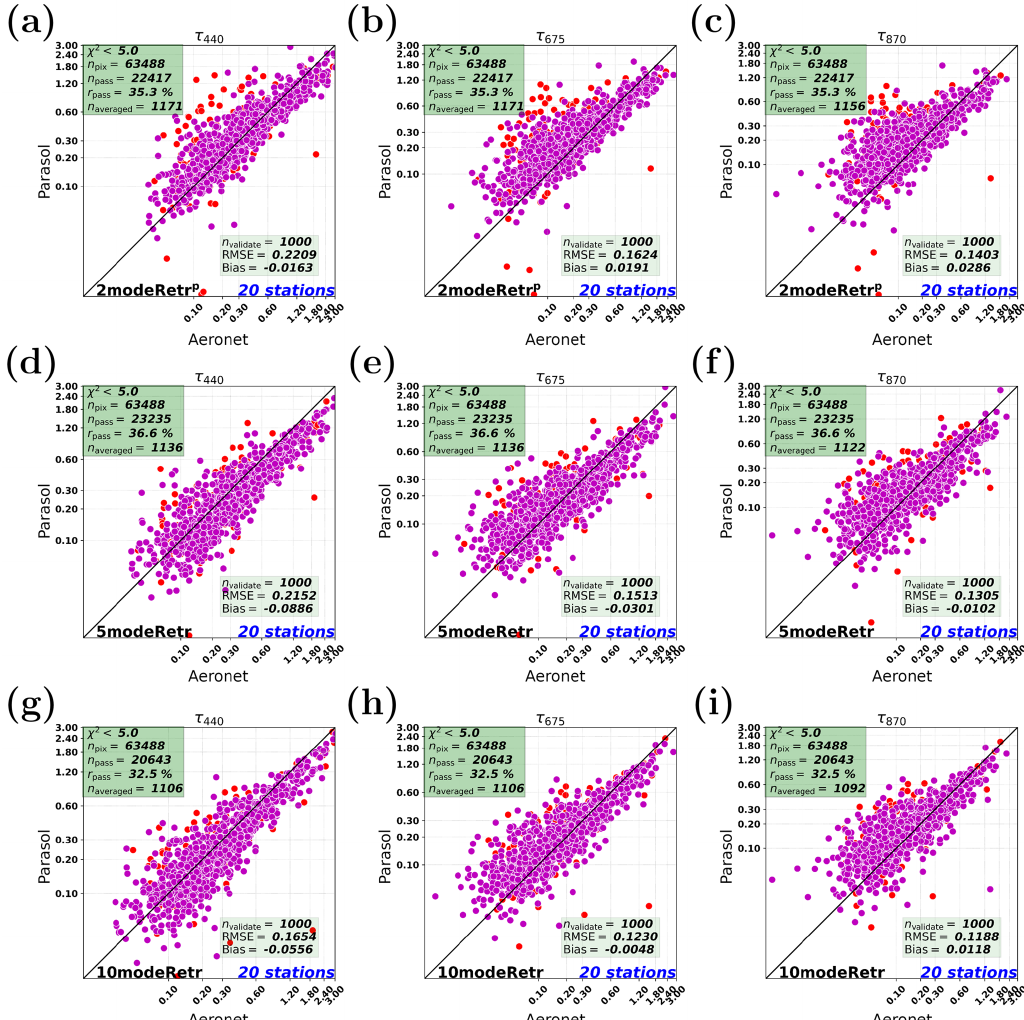
Figure 13. Real data retrievals of AOT among 2modeRetr p , 5modeRetr, and 10modeRetr at different wavelengths. The red and magenta points represent n averaged and n validate points, respectively. Panels (a–c) show 2modeRetr p at 440, 675, and 870nm, respectively. Panels (d–f) show 5modeRetr at 440, 675, and 870nm, respectively. Panels (g–i) show 10modeRetr at 440, 675, and 870nm,